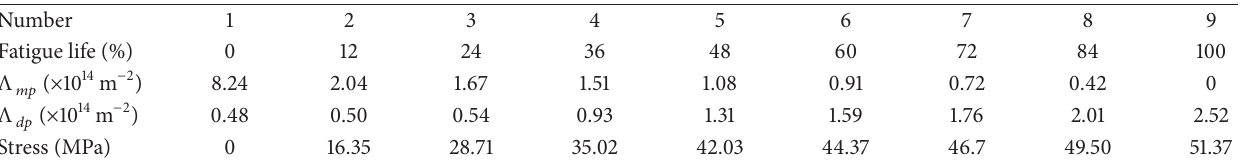
Table 2: Parameters for theoretical models.